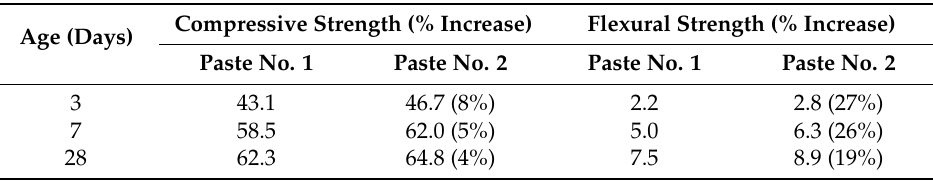
Table 7. Compressive and flexural strengths of cement pastes (in